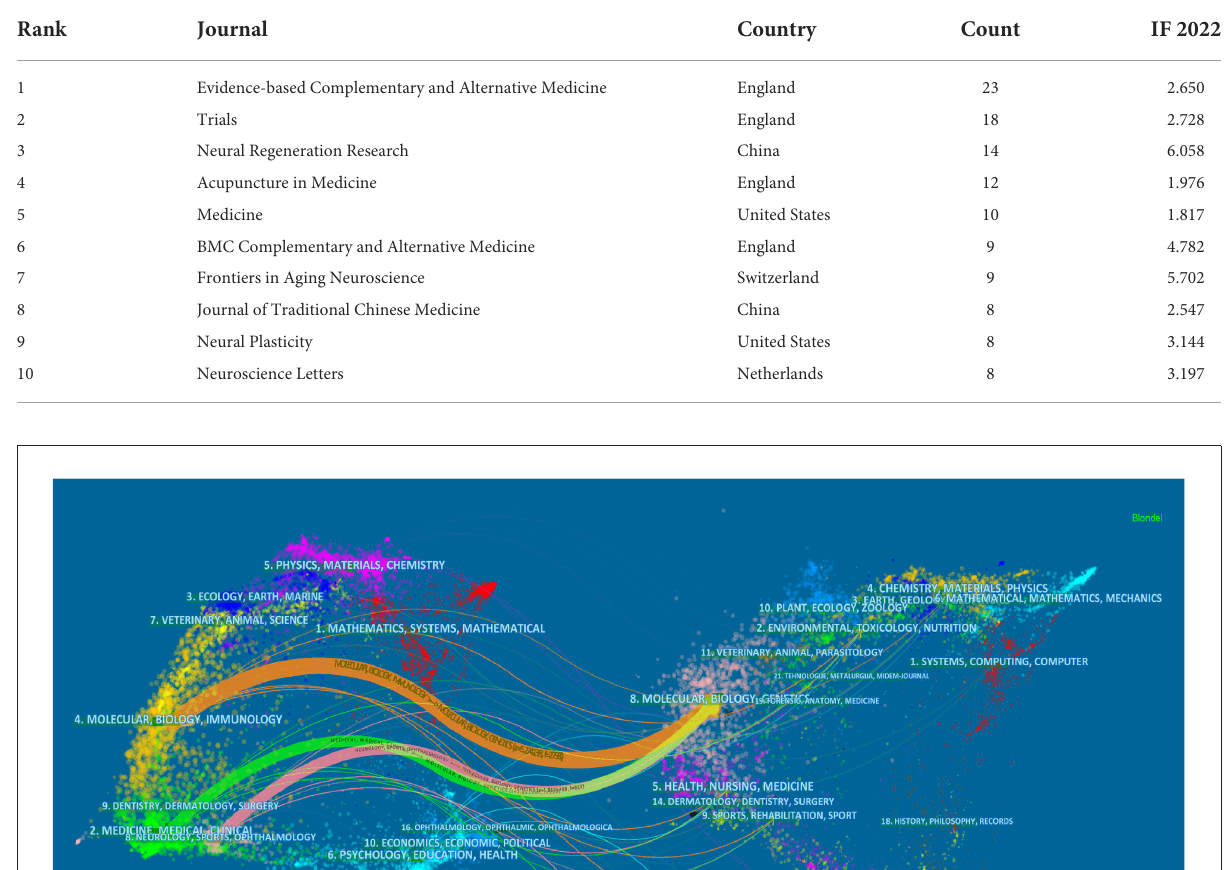
TABLE 1 The top 10 journals that published articles.